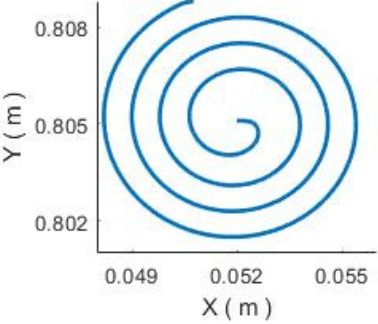
Figure 5. The searching trajectory of the hole.